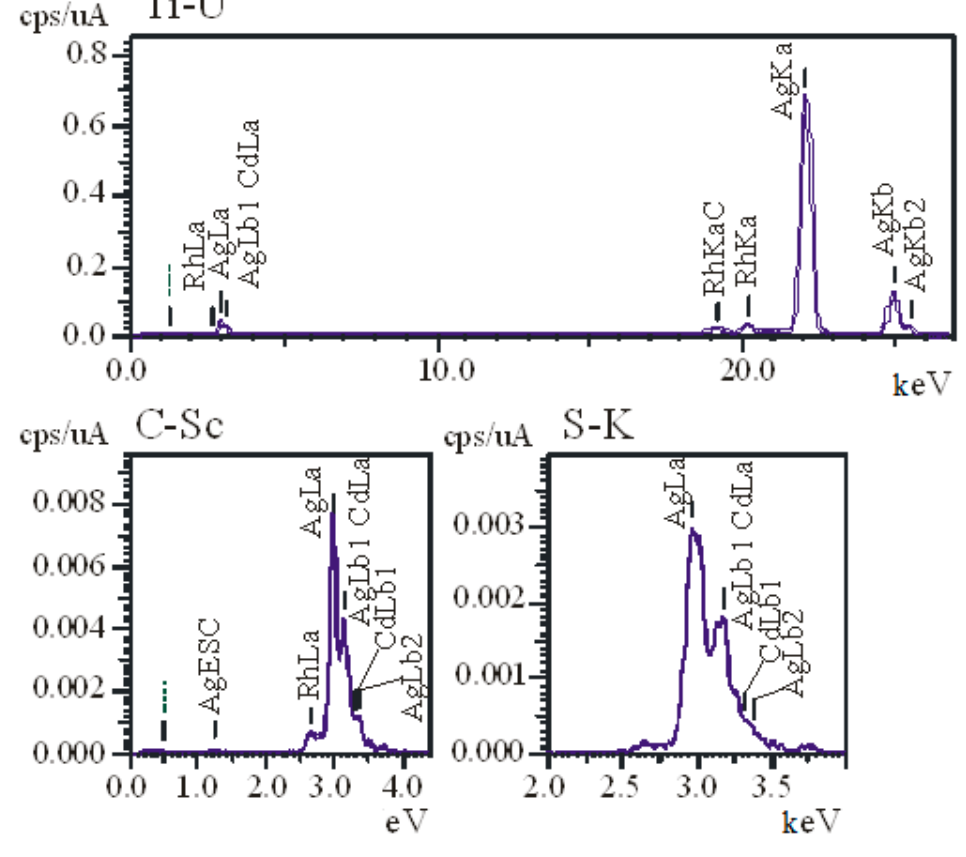
Figure 2. X-ray spectra of Figure 2. X ‐ ray spectra of AgNPs.